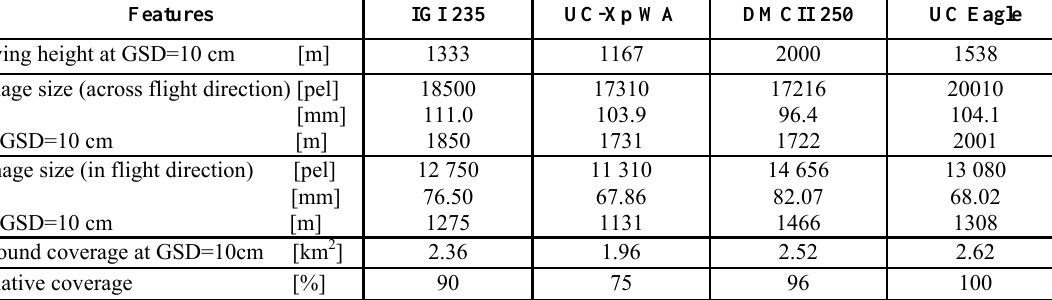
Table 3. Ground coverage of the four new digital